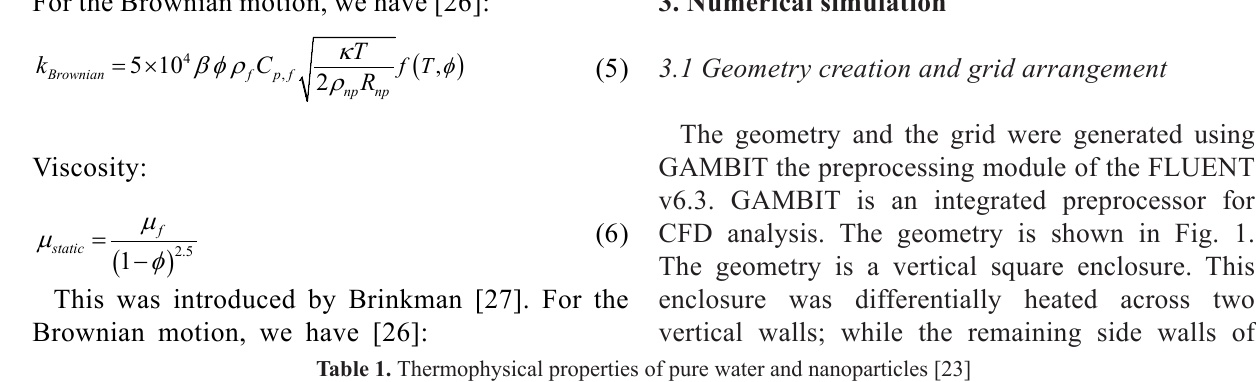
Table 1. Thermophysical properties of pure water and nanoparticles [23]